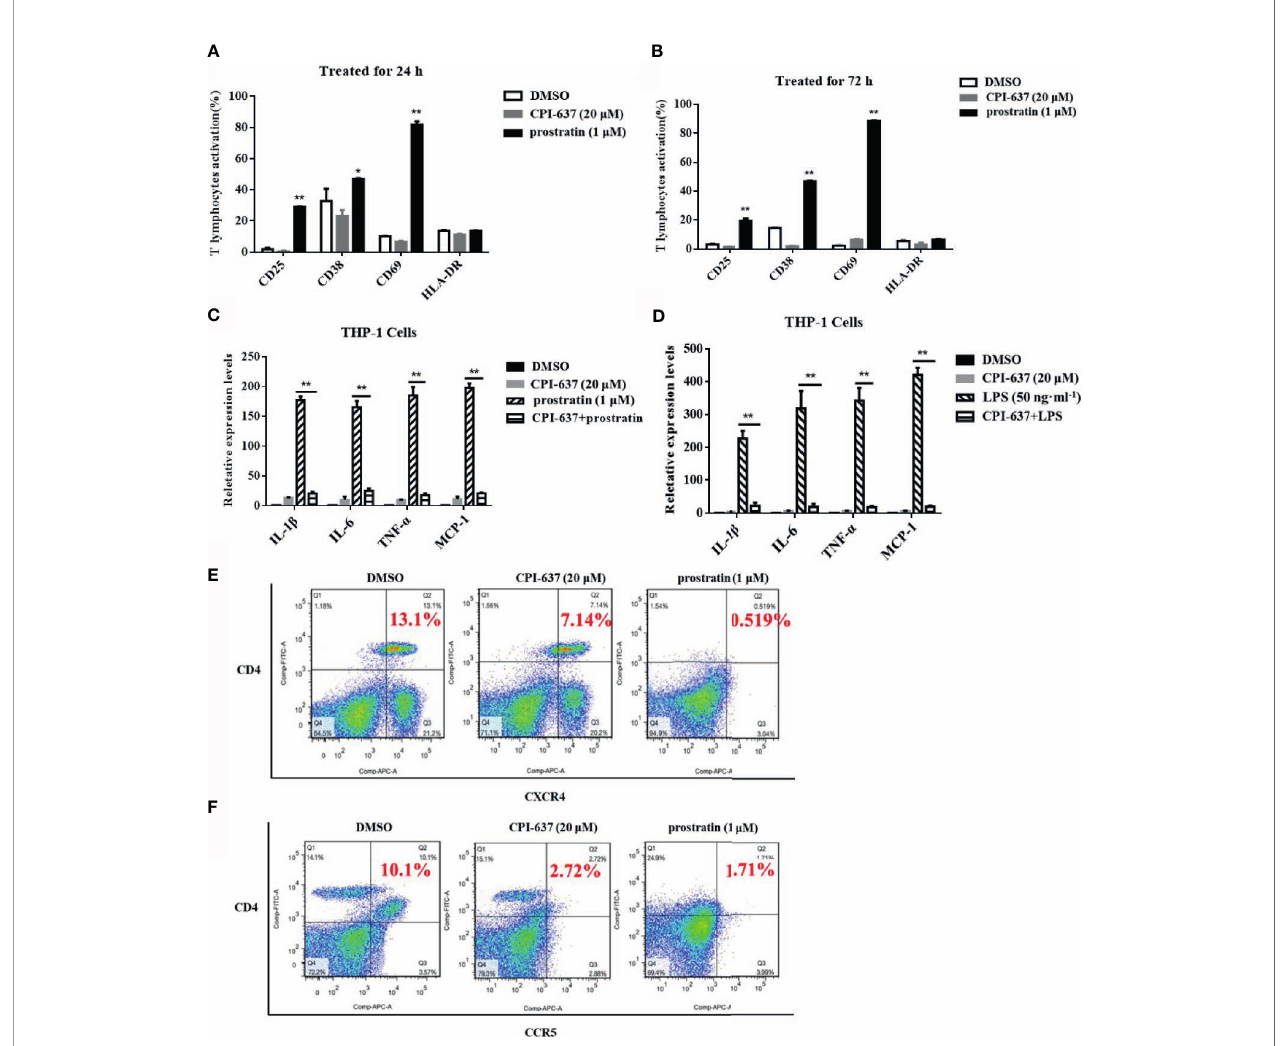
FIGURE 3 | CPI-637 does not up-regulate HIV-1 receptor/coreceptors and does not induce global T-cell activation. After treatment with CPI-637 (20 m M) for 24 (A) or 72 h (B) , the expressions of CD69, CD38, CD25 and HLA-DR in PBMCs from healthy HIV-negative donors were analyzed by fl ow cytometry. (* p < 0.05 vs DMSO control group, ** p < 0.01 vs DMSO control group) After treatment with CPI-637 (20 m M) for 48 h, the expression of pro-in fl ammatory cytokines, including IL- 1 b , IL-6, TNF- a and MCP-1, in THP-1 cells were analyzed by RT-qPCR (C , D) . And fractions of CD4, CXCR4 (E) and CCR5 (F) positive cells in PBMCs were analyzed by fl ow cytometry. (* p < 0.05 vs prostratin group, ** p < 0.01 vs prostratin